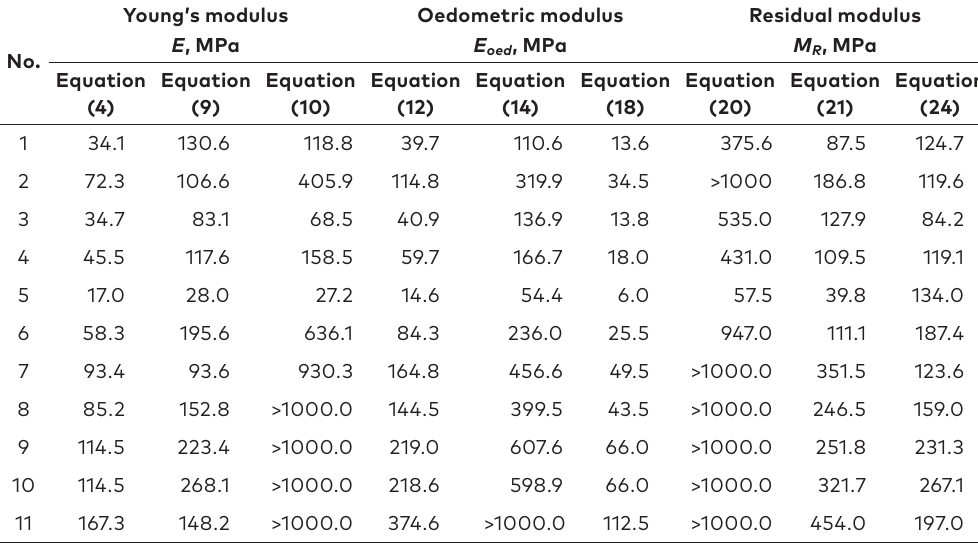
Lithuania. Table 5. Results of determination of coarse soil deformation